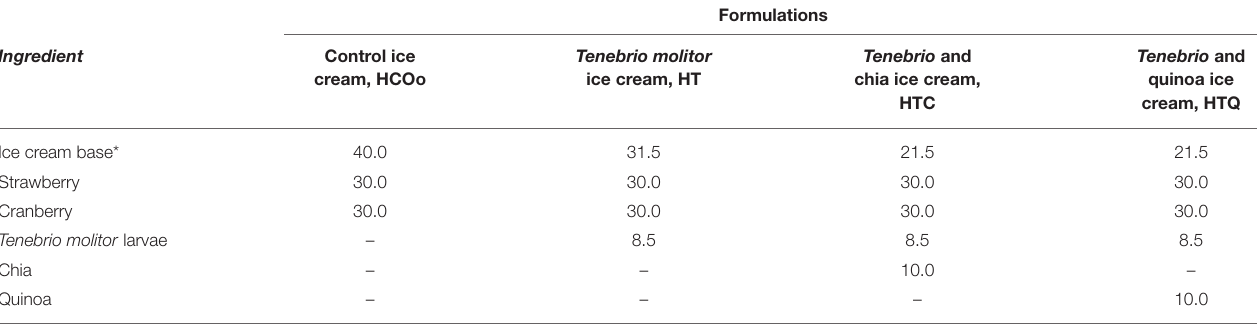
TABLE 5 | Composition of the four formulations (%).